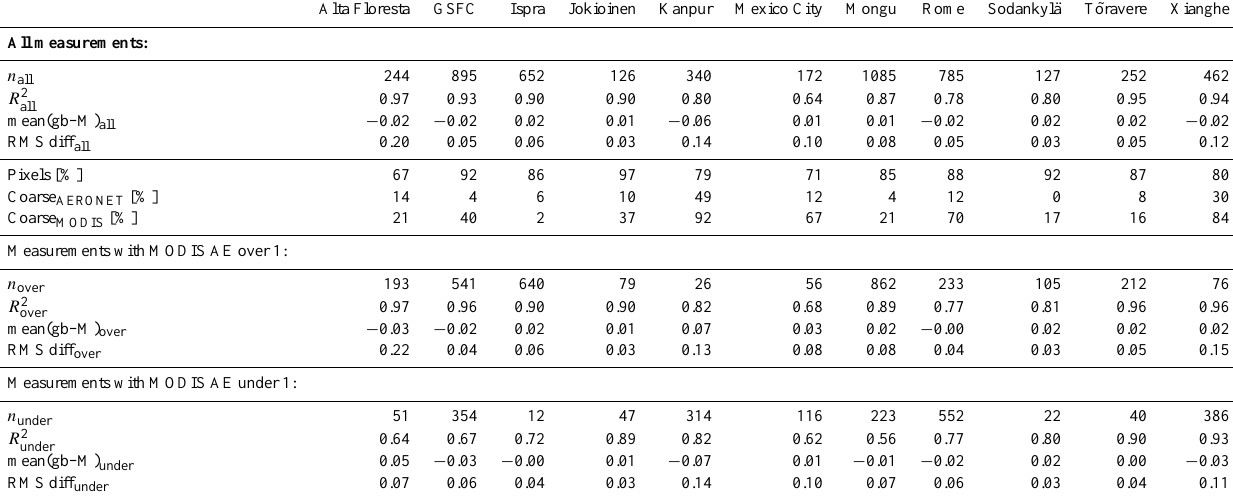
Table 2. Statistics of the concurrent AERONET/PFR and MODIS AOD measurements. Subscript “all” refers to all coexistent measure- ments, “over” refers to measurements with MODIS AE over 1, and “under” refers to measurements with MODIS AE under 1. n is the number of measurements, R 2 is the correlation coefficient, mean(gb–M) is the average difference between the ground-based and MODIS measurements, RMS diff is the Root-Mean-Square Difference, and Pixels is the percentage of pixels within the expected accuracy of MODIS. Coarse AERONET and Coarse MODIS are the percentages of coarse particle measurements at each site based on AERONET and MODIS data,